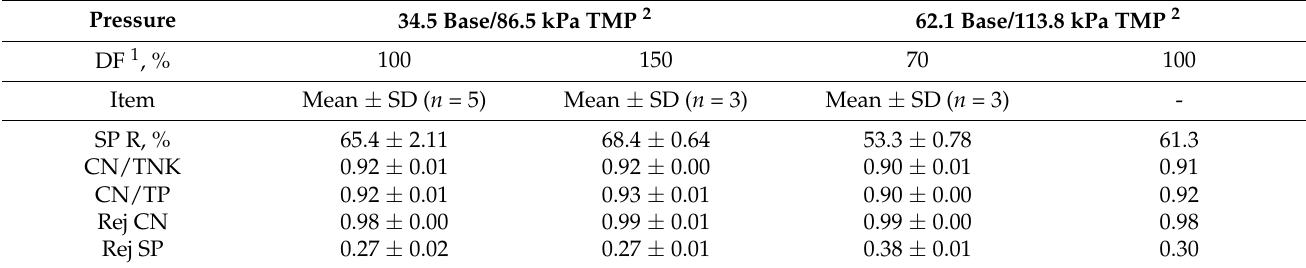
Table 3. Mean ± SD of serum protein removal (SP R, %), casein-to-total-protein (CN/TKN), casein-to-true-protein (CN/TP) ratio, and rejection of casein (Rej CN) and serum protein (Rej SP) data obtained from pilot plant experiments. Pressure 34.5 Base/86.5 kPa TMP